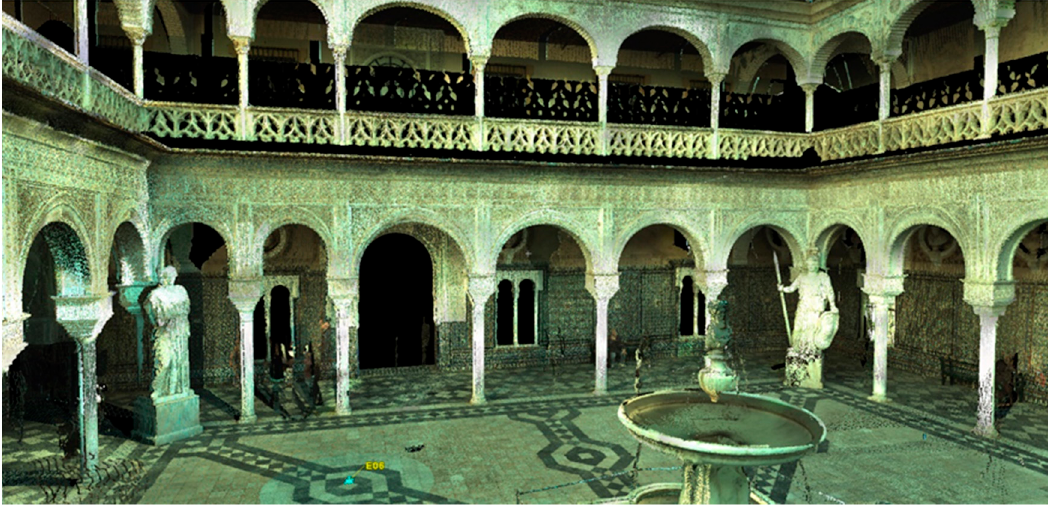
Figure 2. View of the main patio of Casa de Pilatos.